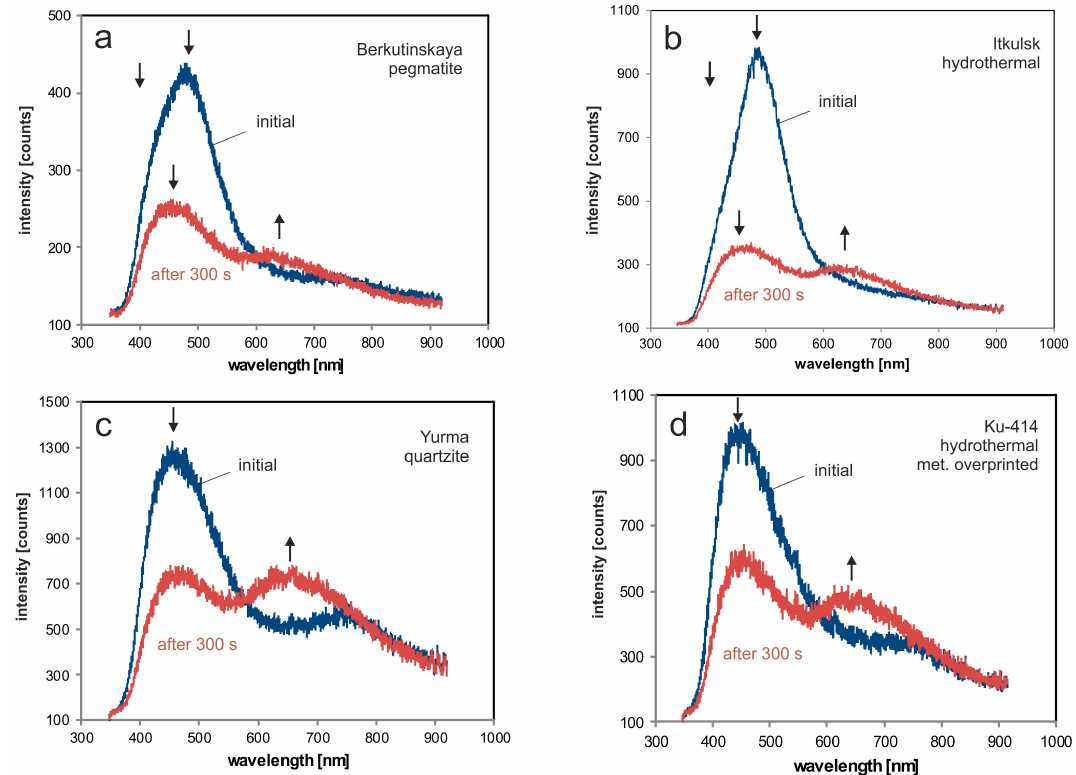
Figure 4. Representative CL emission spectra of quartz of different origin (blue spectrum = initial, red spectrum = after 5 min of electron irradiation): ( a ) pegmatite quartz; ( b ) hydrothermal vein quartz; ( c ) quartzite; ( d ) tectonically deformed and partially re-crystallized hydrothermal quartz.